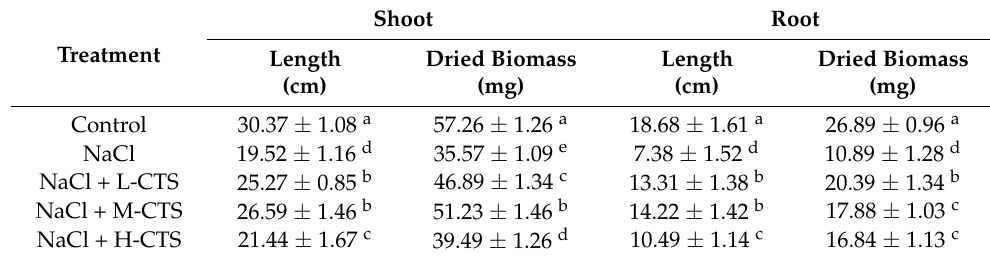
Table 1. Growth parameters of durum wheat seedlings grown under control, NaCl stress and NaCl stress + CTS